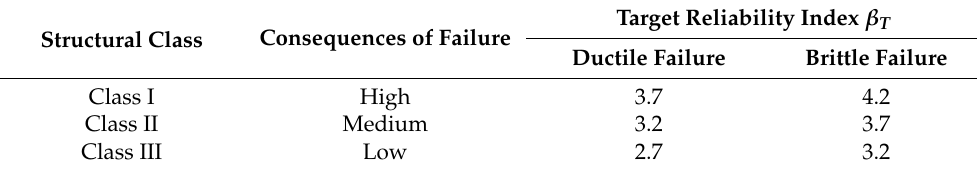
Table 7. Target reliability index β T at the ultimate state of structures under the 50-year period [4].